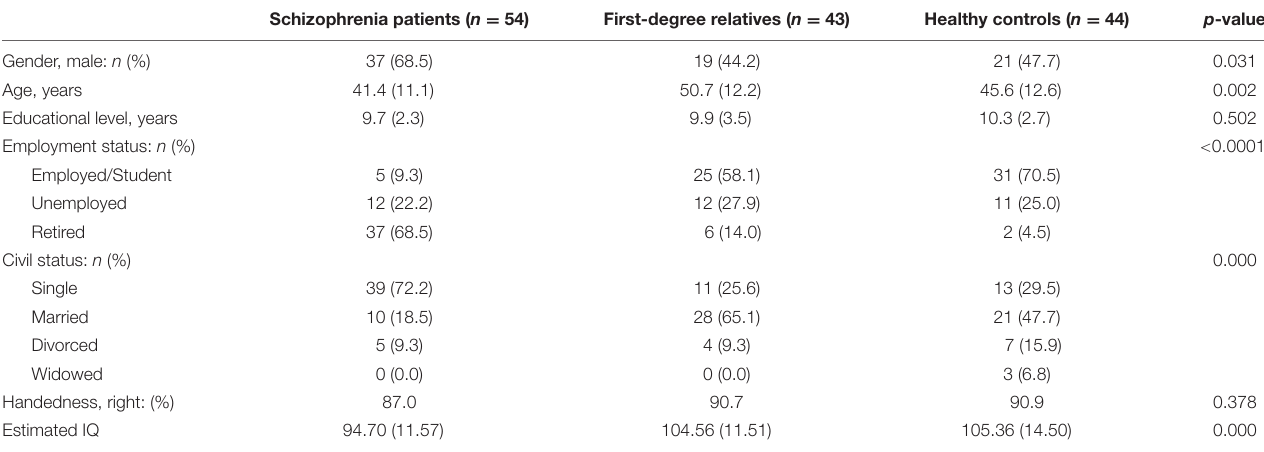
TABLE 3 | Socio-demographic characteristics of the sample and comparison between